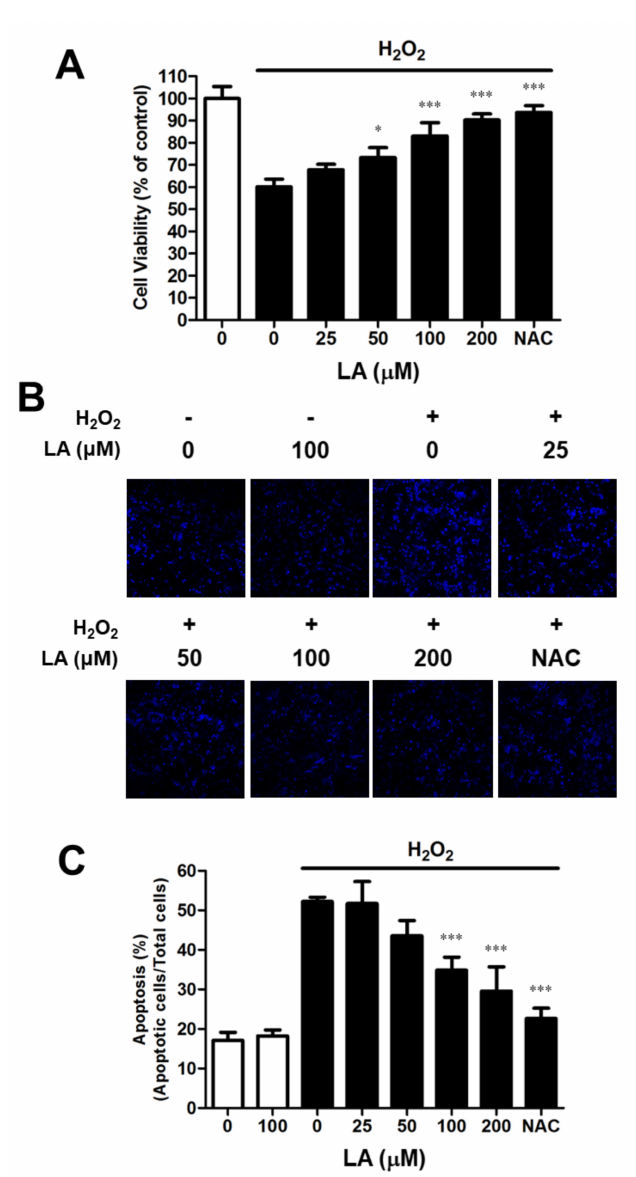
Figure 1. Linoleic acid prevents oxidative stress-induced cell death in C2C12 myoblasts. C2C12 myoblasts were seeded, and the medium was then replaced with serum-free DMEM containing LA (0–200 mM) for 24 h. After pre-incubation, C2C12 myoblasts were treated with 1 mM H 2 O 2 for 2 h. The cell viability was assessed by using the EZ-Cytox cell viability kit. Absorbance at 450 nm was measured using a microplate reader. ( A ) Effect of LA on H 2 O 2 -induced cell viability in C2C12 myoblasts. The cell viability was calculated according to the following equation: cell viability (%) = [(absorbance of the H 2 O 2 -treated sample/absorbance of the H 2 O 2 -untreated control) × 100]. Each value indicates the mean ± SD ( n = 5). ( B ) Effect of LA on apoptosis by oxidative stress in C2C12 myoblasts. C2C12 myoblasts were fixed with 4% para -formaldehyde in PBS for 30 min and mounted using a mounting medium with DAPI. Imaging data were acquired on a confocal microscope. DAPI staining was detected at wavelengths of 358 and 461 nm. ( C ) Quantitating apoptotic cells. Apoptotic cells were measured using the Image J software. Apoptosis was calculated according to the following equation: apoptosis (%) = [(number of apoptotic cells/number of total cells) × 100]. Each value indicates the mean ± SD ( n = 4). * p < 0.05 and *** p < 0.001. vs. H 2 O 2 alone. The effect of LA was compared with that of 2 mM N -acetyl- L -cysteine